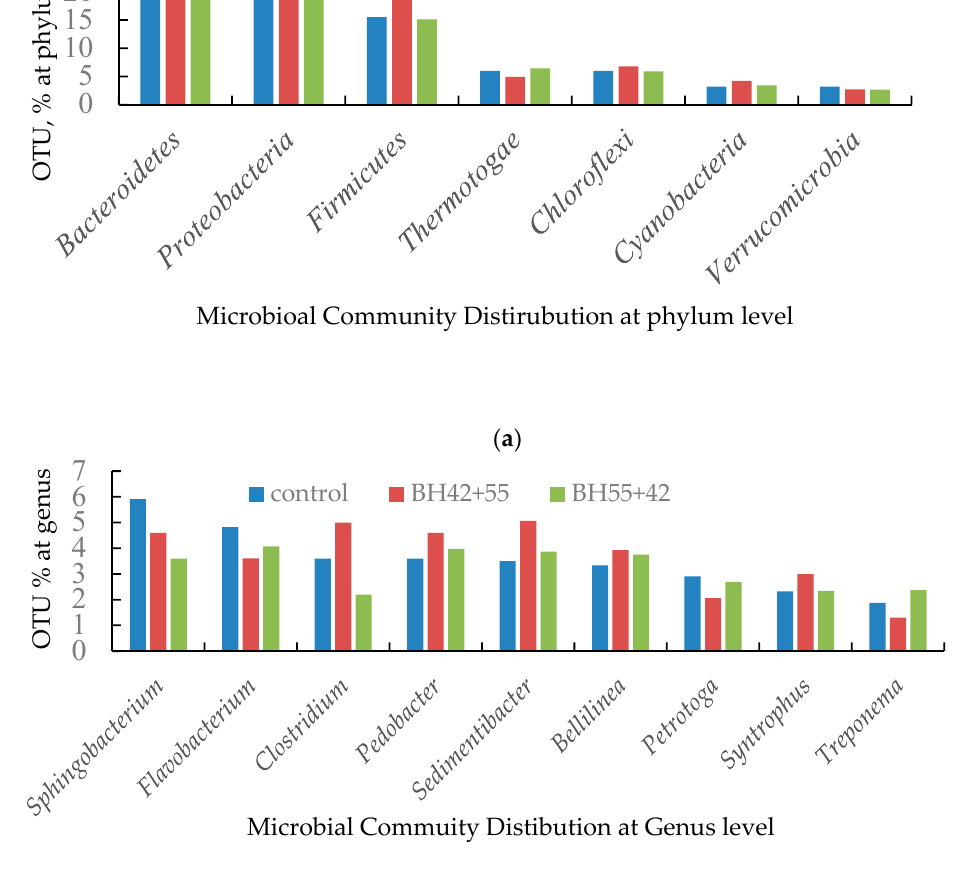
Figure 7. Taxonomic classification of the dominant microbial communities; ( a ) classification at phylum level, and ( b ) classification at genus level.